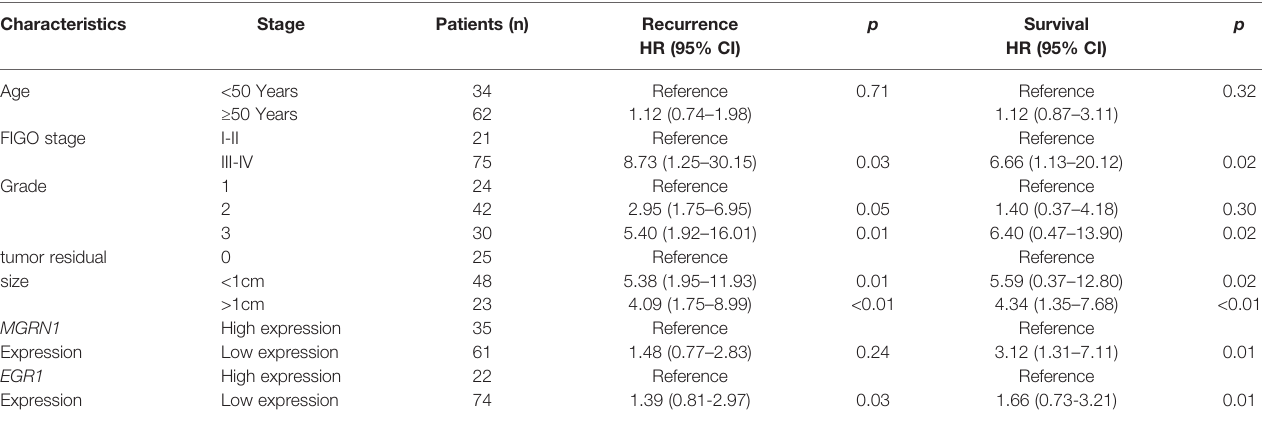
TABLE 1 | Clinical characteristics of 96 HGSOC